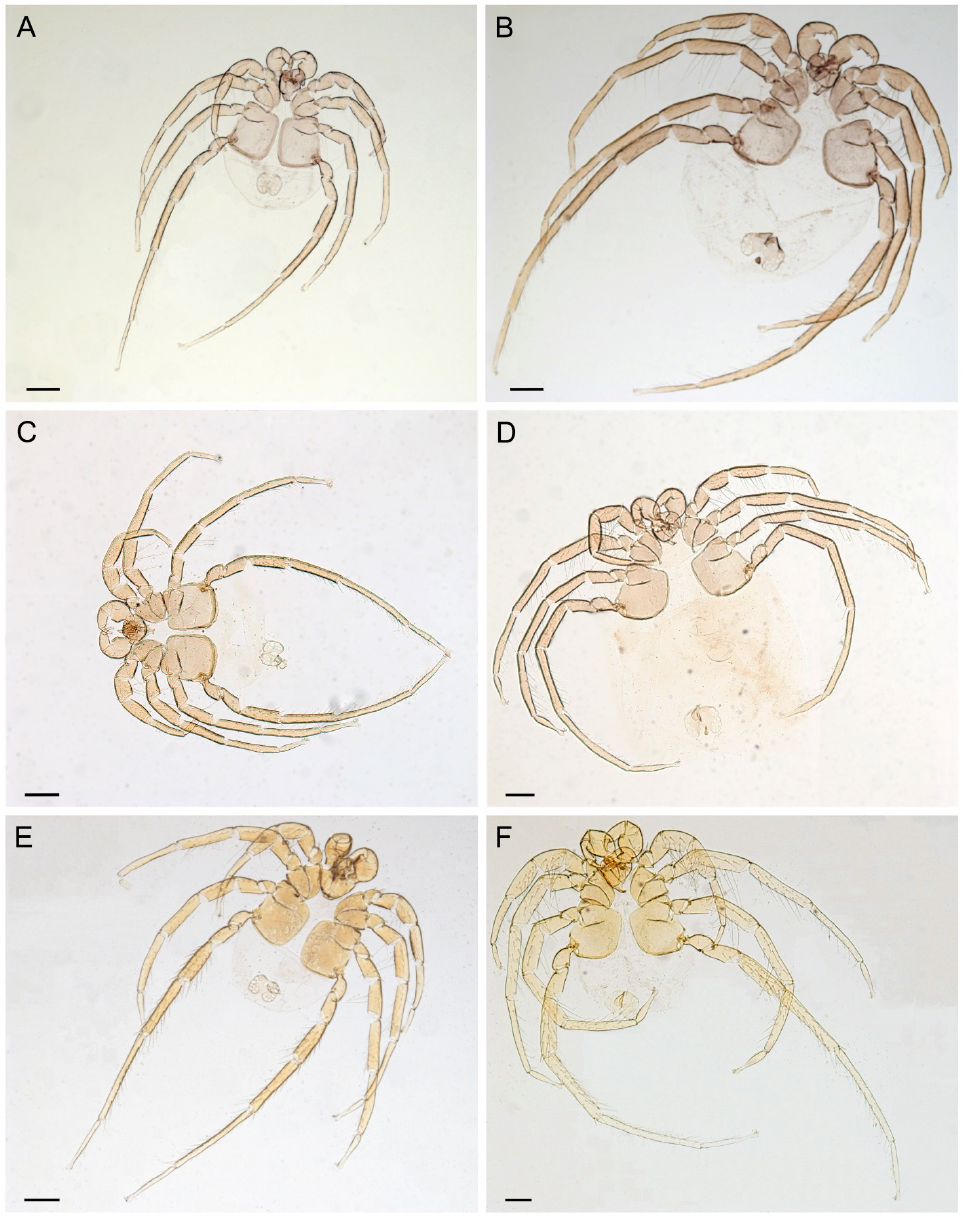
Figure 4. Type series of new mussel-associated mites from Southeast Asia (photos of permanent slides). ( A , B ) U. ( Myanmaratax ) savadiensis subgen. and sp. nov. : male holotype RMBH Hyd 603 ( E ) and female paratype RMBH Hyd 603 ( B ). ( C , D ) U. ( My. ) generosa sp. nov. : male holotype RMBH Hyd 413 ( C ) and female paratype RMBH Hyd 413 ( D ). ( E , F ) U. ( My. ) trapezidens sp. nov. : male holotype RMBH Hyd 388 ( E ) and female paratype RMBH Hyd 388 ( F ). Scale bars = 200 μ m. (Photos: Yulia E. Chapurina).